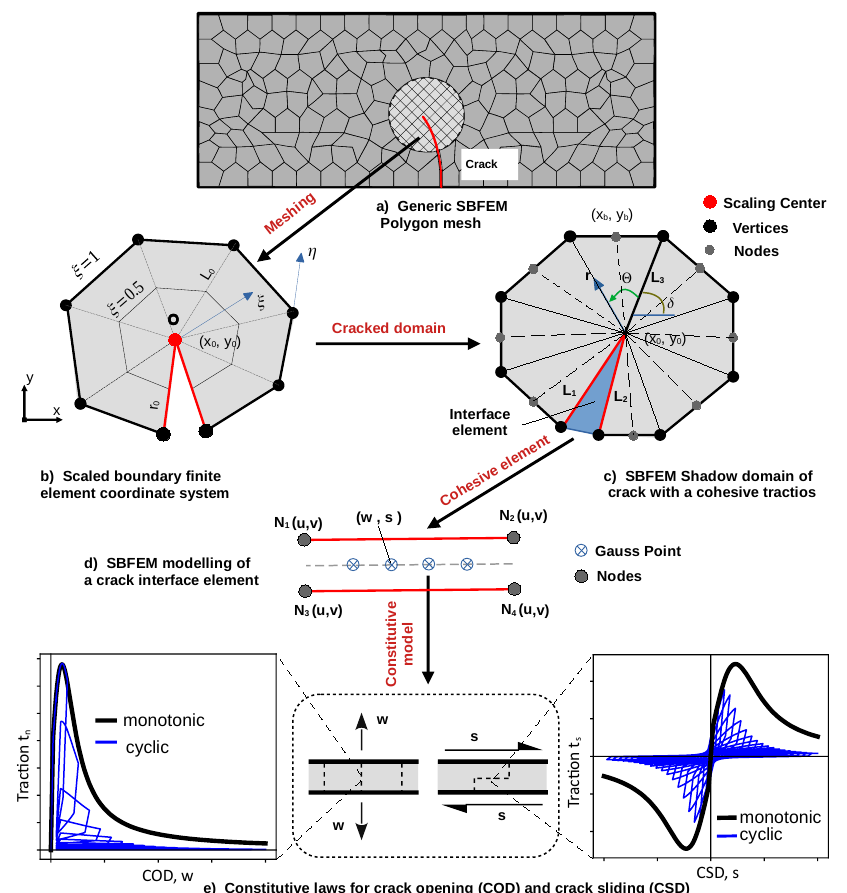
Figure 1. The concept of a cohesive crack model using the scaled boundary finite element